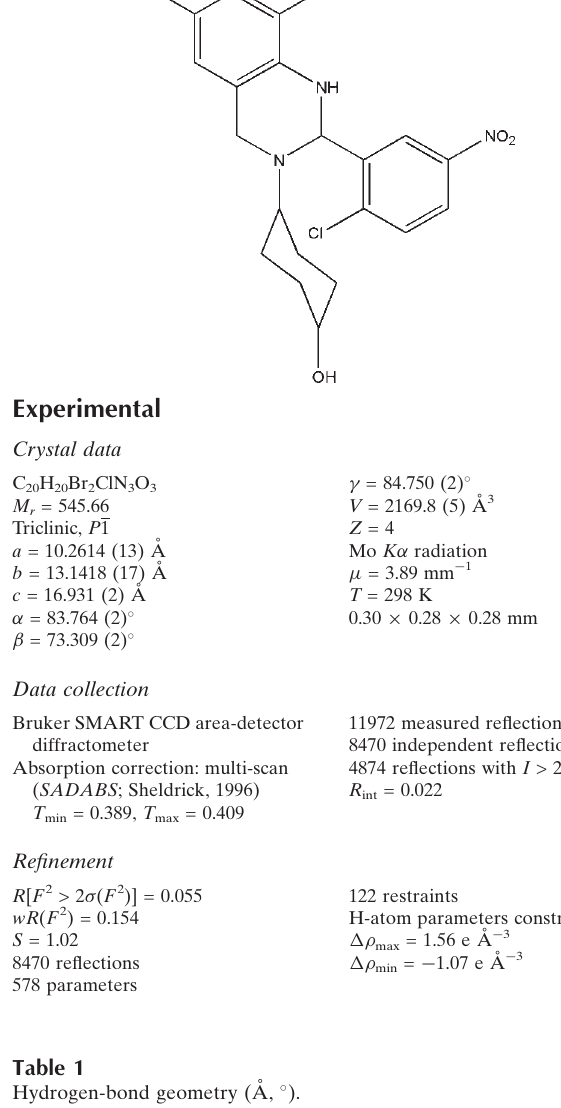
Hydrogen-bond geometry (A˚ , (cid:2) ). D —H (cid:3)(cid:3)(cid:3)